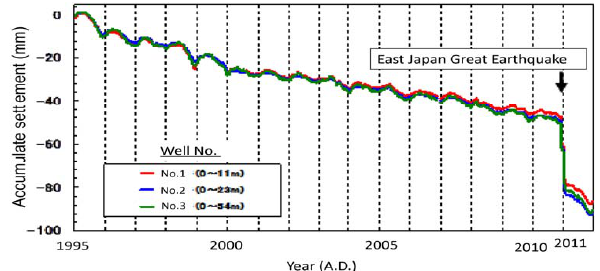
Figure 2. Variation of settlement before and after the Tohoku Earth- quake (at Kamomachi of